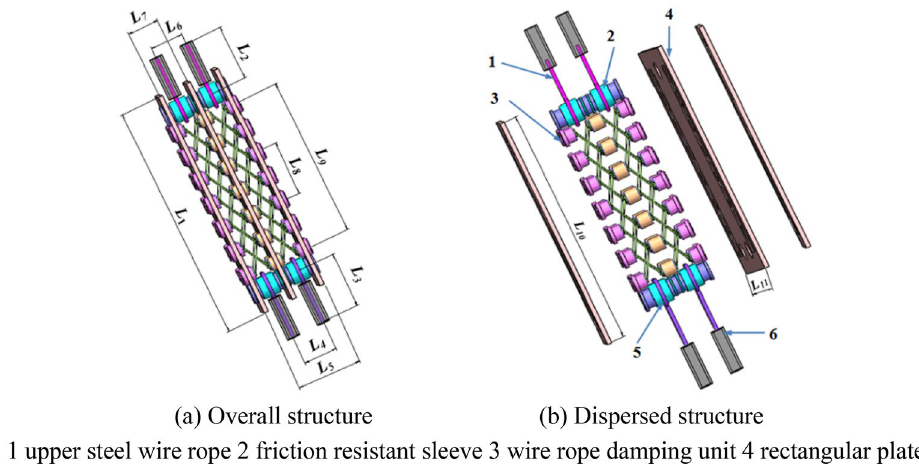
Figure 2. 3D structure of vibration reduction system.